Question: Describe this figure in one sentence.
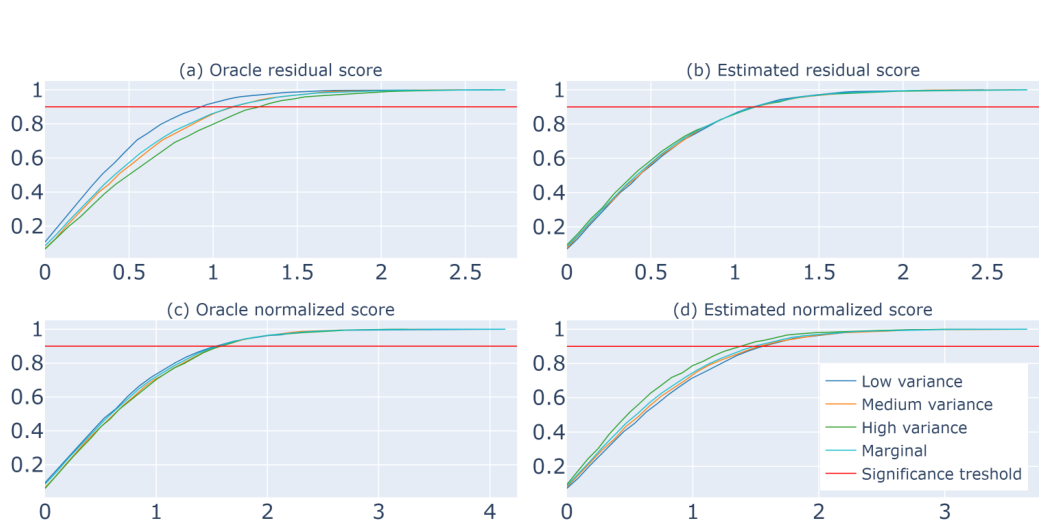
Answer: (a) and (c): CDF plots of the residual and σ-normalized nonconformity scores for the oracle. (b) and (d): CDF plots of the residual and σ-normalized nonconformity scores for the misspecified model in Equation (54) The (empirical) distributions are shown marginally (all data) and for the taxonomy classes corresponding to equal-frequency binning of the estimated variance (n = 3 classes).